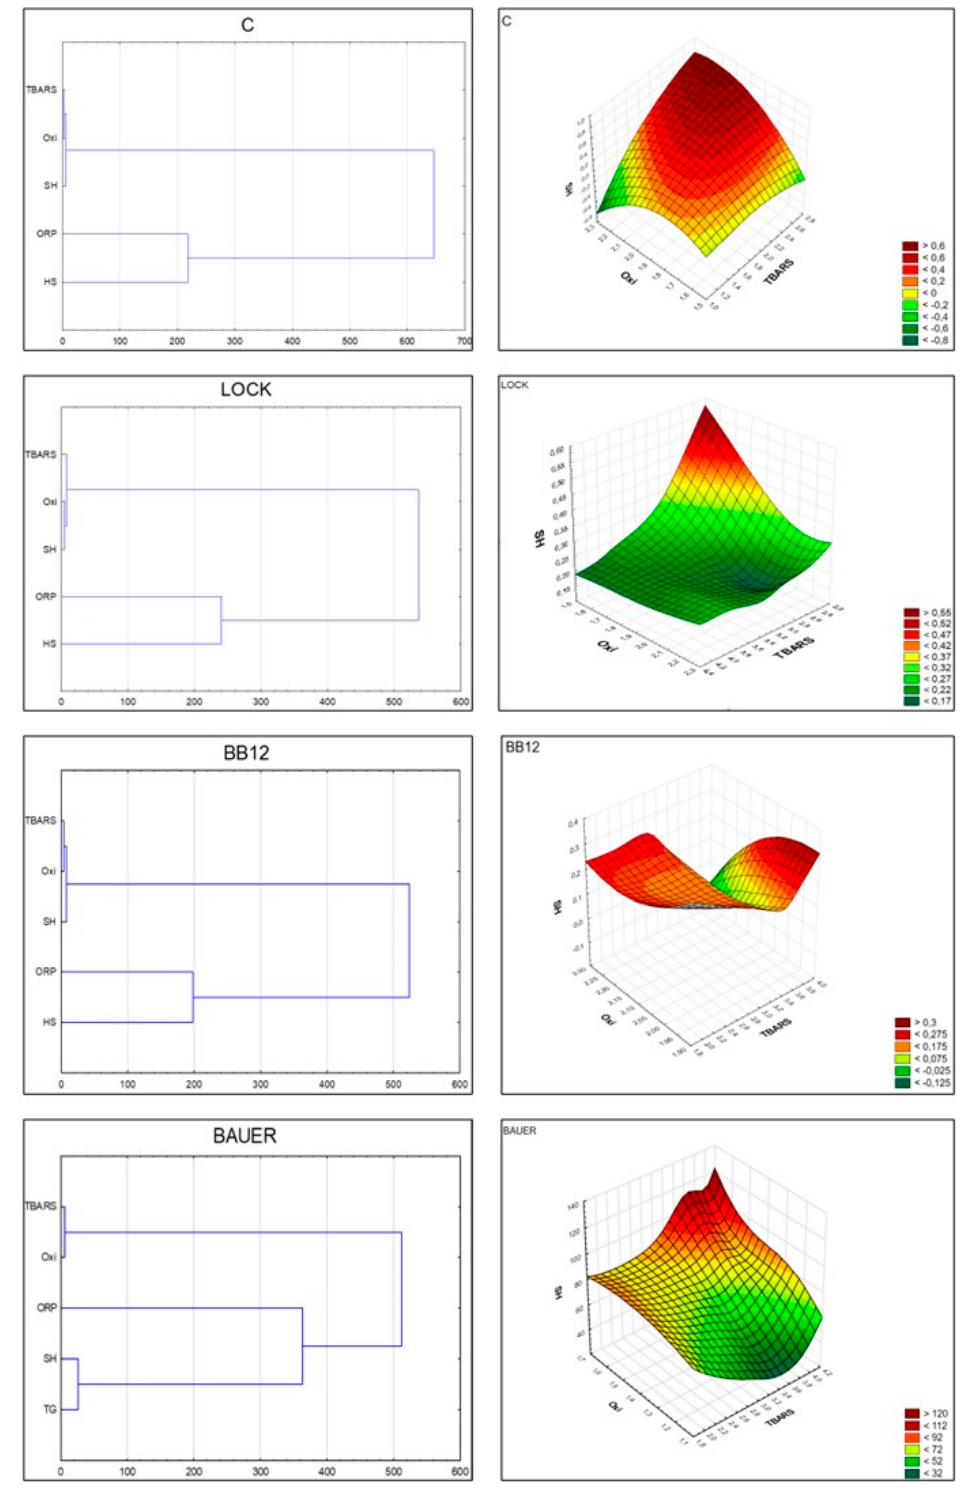
Figure 3. Graphical representation of dependencies for oxidative indicators as a dendrogram ( left ) and 3D chart showing the interaction between TBARS (x), Ox i (y), and SH (z) ( right ).